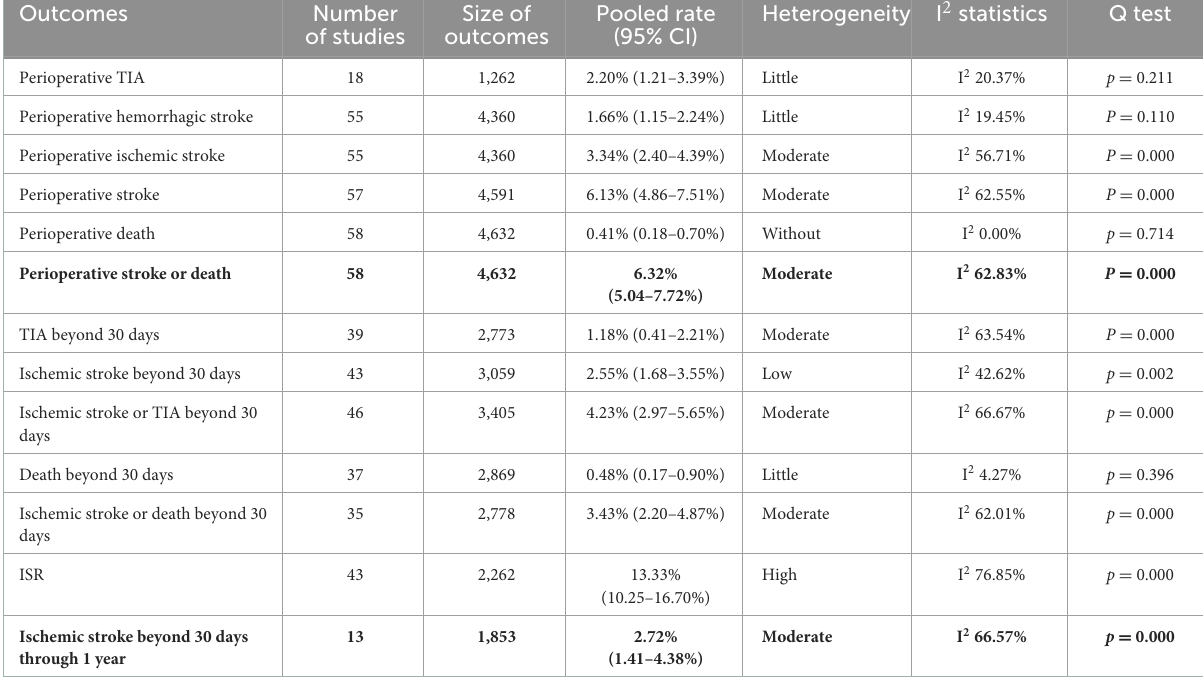
TABLE 2 Pooled rate of perioperative complications and long-term outcomes. Outcomes Number